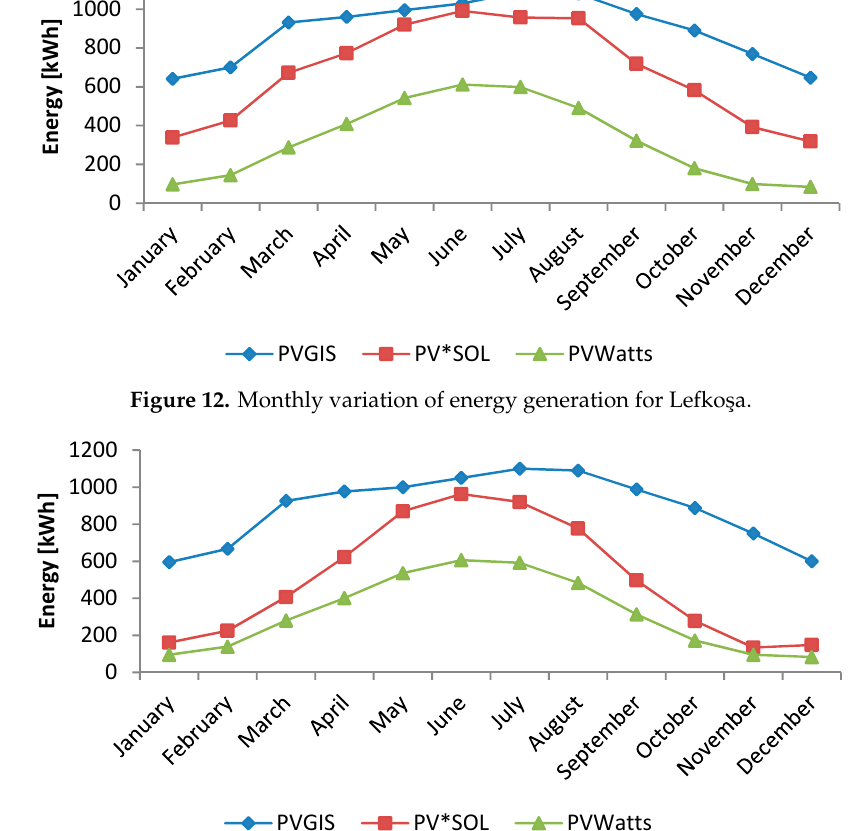
Figure 14. Monthly variation of energy generation for Gazima ğ usa. 3.5.3. Performance Comparison Based on PV*SOL, the annual energy consumption of the household is calculated as 3500 kWh. Based on the simulation result, PV supplies 1378 kWh (39.37%) and the remaining 2122 kWh (60.63%) is covered from the grid, as shown in Table 9. Moreover, Tab1e 9 shows a performance comparison of the 6.4 kWp rooftop PV system at Lefko ş a using three simulation software (PVGIS,